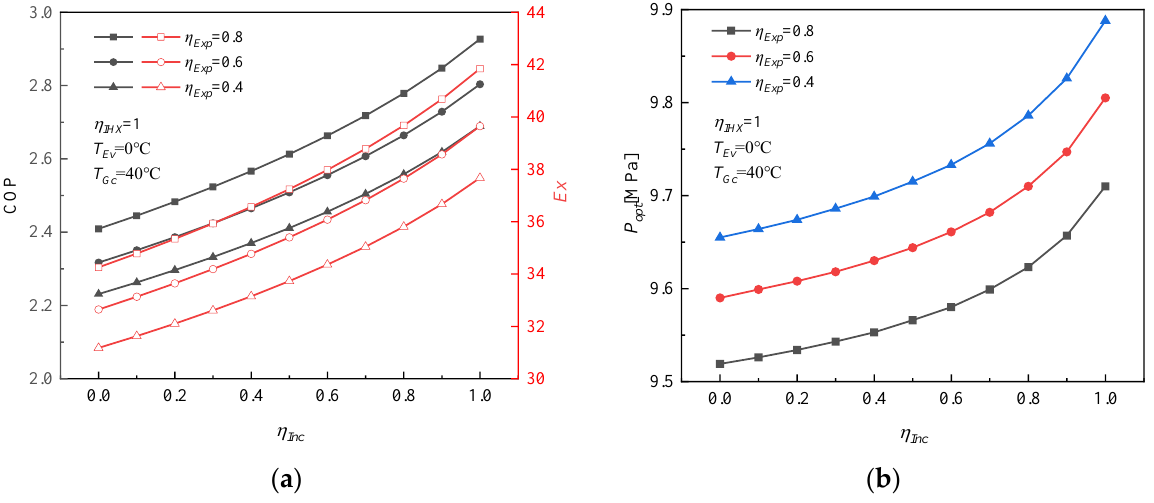
Figure 8. Effect of η Inc on system performance at different η Exp : ( a ) System performance variation at different η Inc ; ( b ) Optimal discharge pressure.